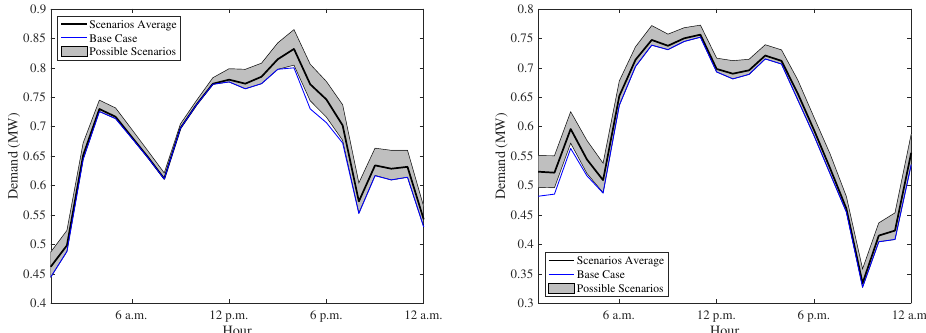
Figure 10. Demand profile on weekdays ( left ) and weekends ( right ) of the feeder with 20%